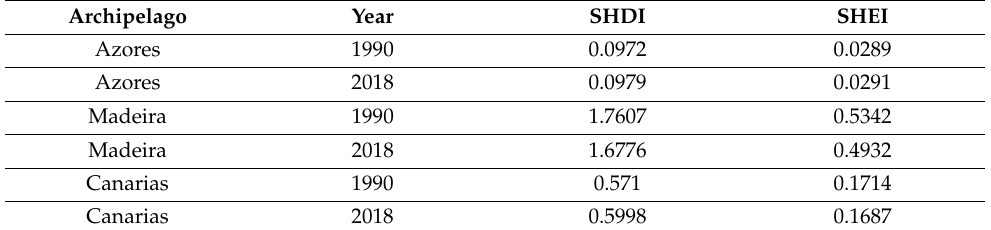
Table 14. Shannon’s Diversity Index and Shannon’s Everness Index values for the archipelagos. Archipelago Year SHDI Azores